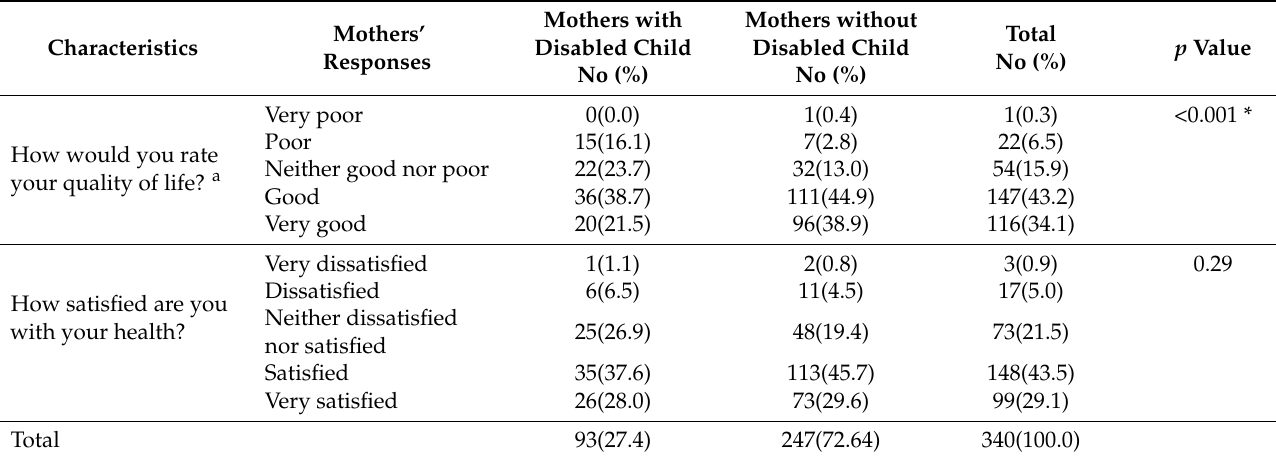
Table 2. Comparison of overall QOL and health satisfaction items among mothers of children with disabilities and mothers of children without disabilities during the COVID-19 lockdown.